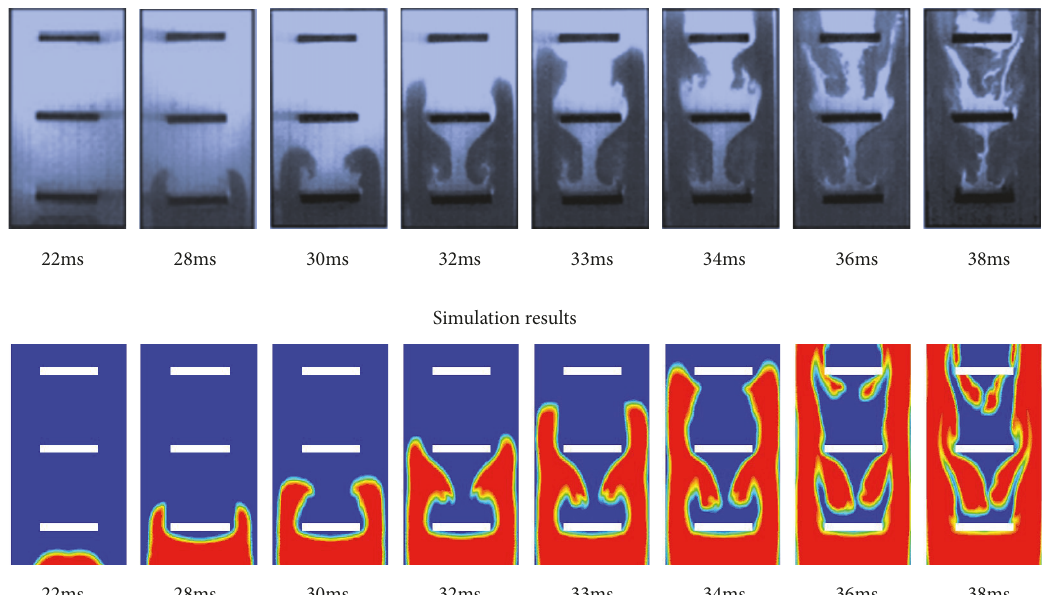
Figure 3: Comparison between experimental and simulated flame propagation at different times after ignition.